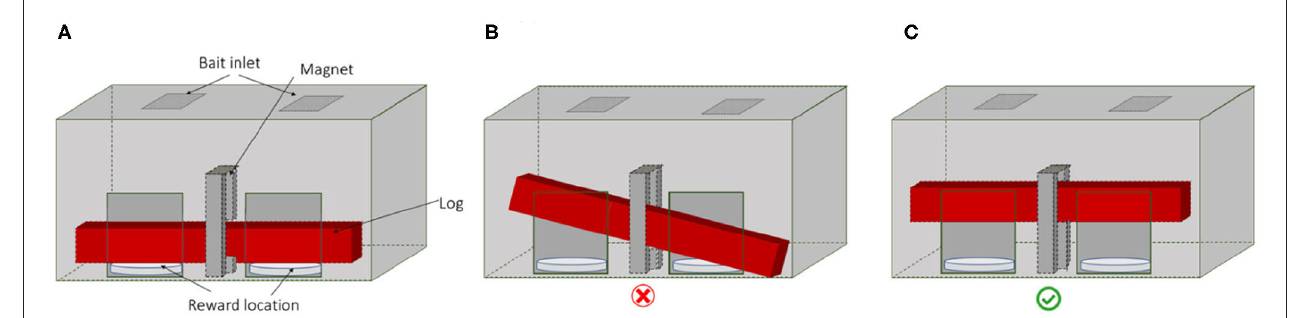
FIGURE 1 | The apparatus in three positions: (A) log is down; (B) if only one pig lifts the log or if two pigs lift the log but unevenly or not high enough then the magnet does not hold the log and no reward is provided; (C) two pigs lift the log to the top magnet and food rewards are provided.